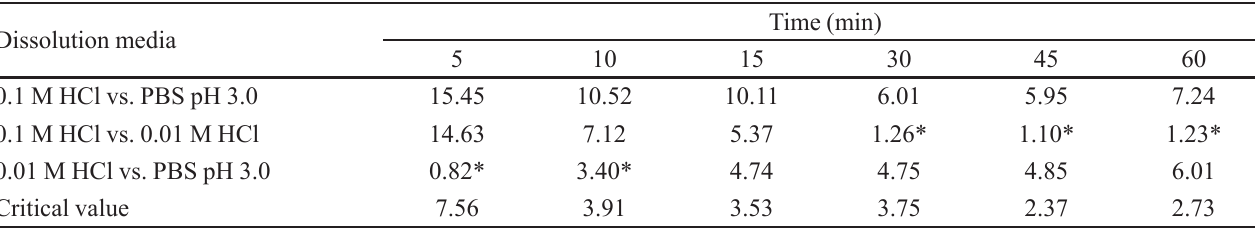
TABLE II - Duncan test ( α=0.05) for MMF-IR dissolution profiles in the media 0.1 M HCl, 0.01 M HCl and PBS pH 3.0 using UV